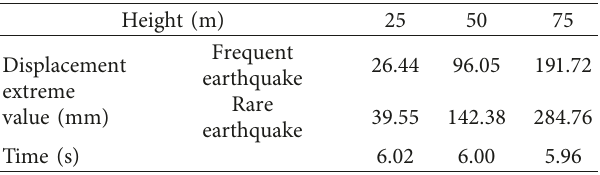
Figure 5: El-Centro wave acceleration time-history curve. Table 2: Displacement extreme values at several